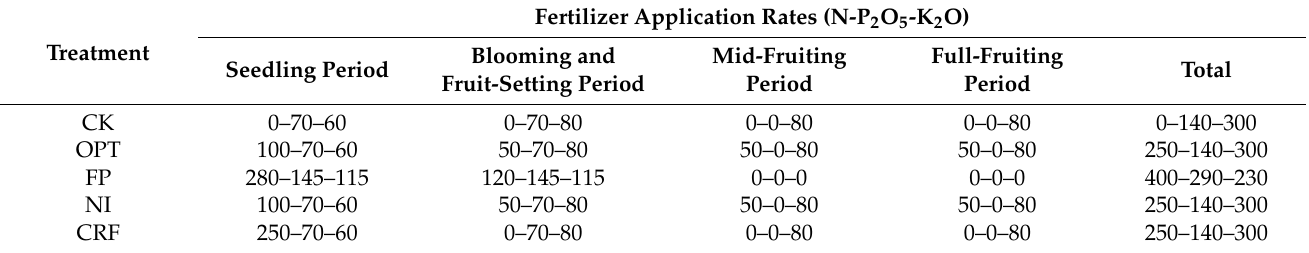
Table 1. Fertilizer application rates at different growth stages under different treatments (kg ha − 1